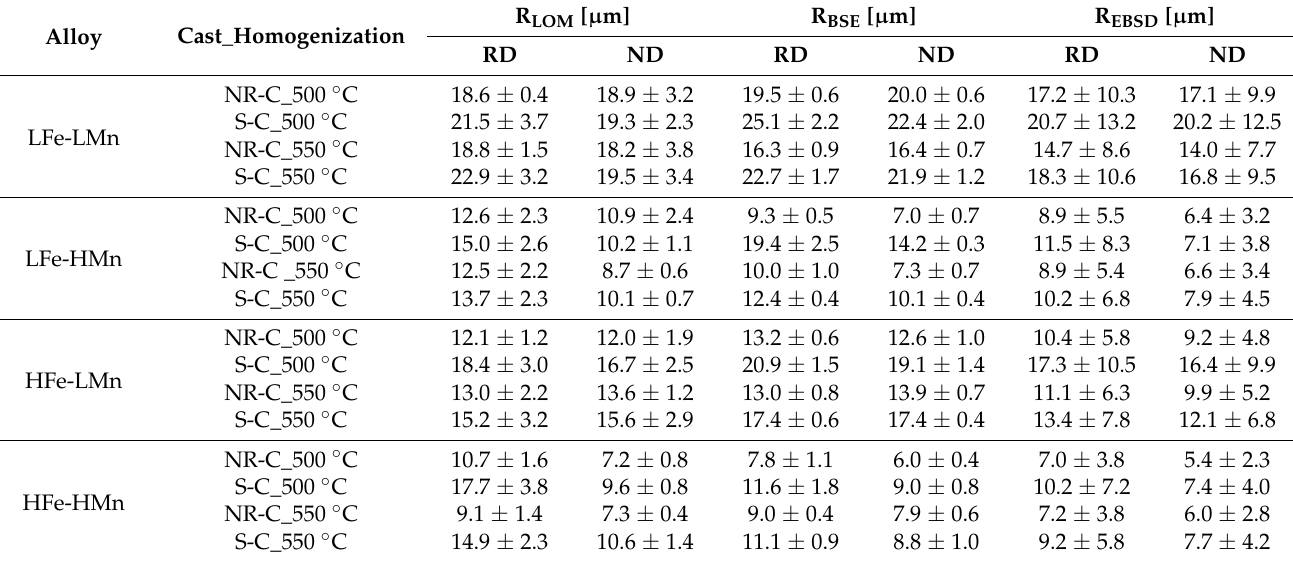
Table 3. Grain size results for 35% CRD samples from LOM, BSE and EBSD